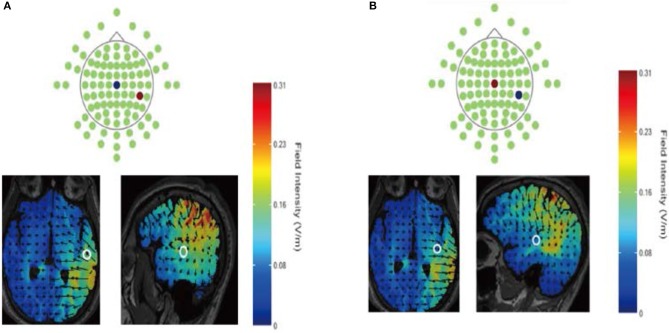
Direct current flow during anodal (A) or cathodal (B) stimulation using the HD-Explore software (Soterix Medical Inc., New York). Electrodes were placed over the CP6 and Cz according to the International EEG 10–10 system. The anode is depicted in red; the cathode is depicted in blue.